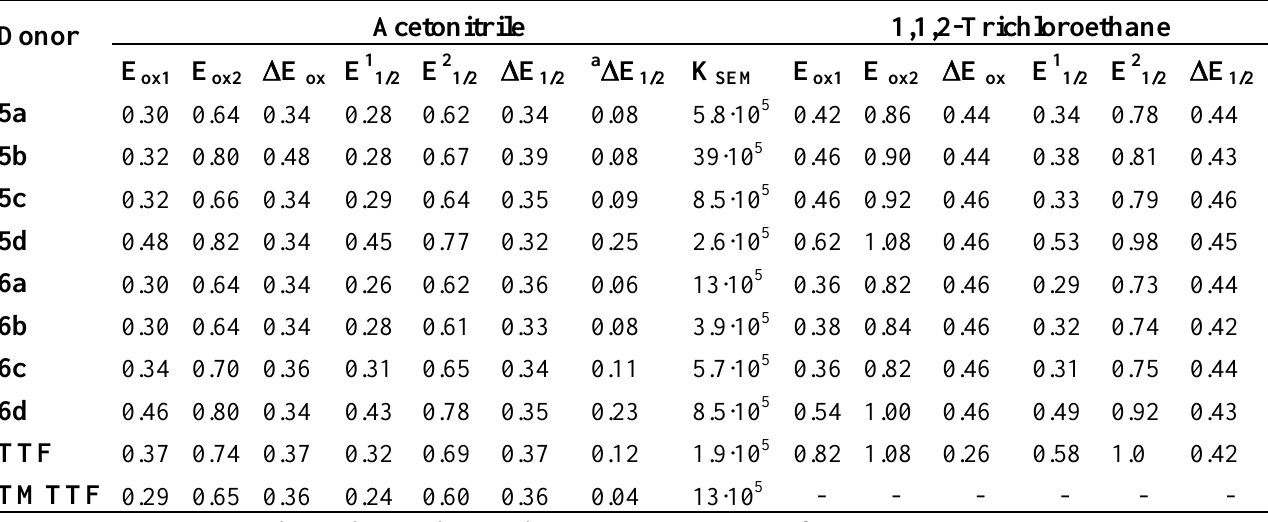
data of 5a-d and SEM